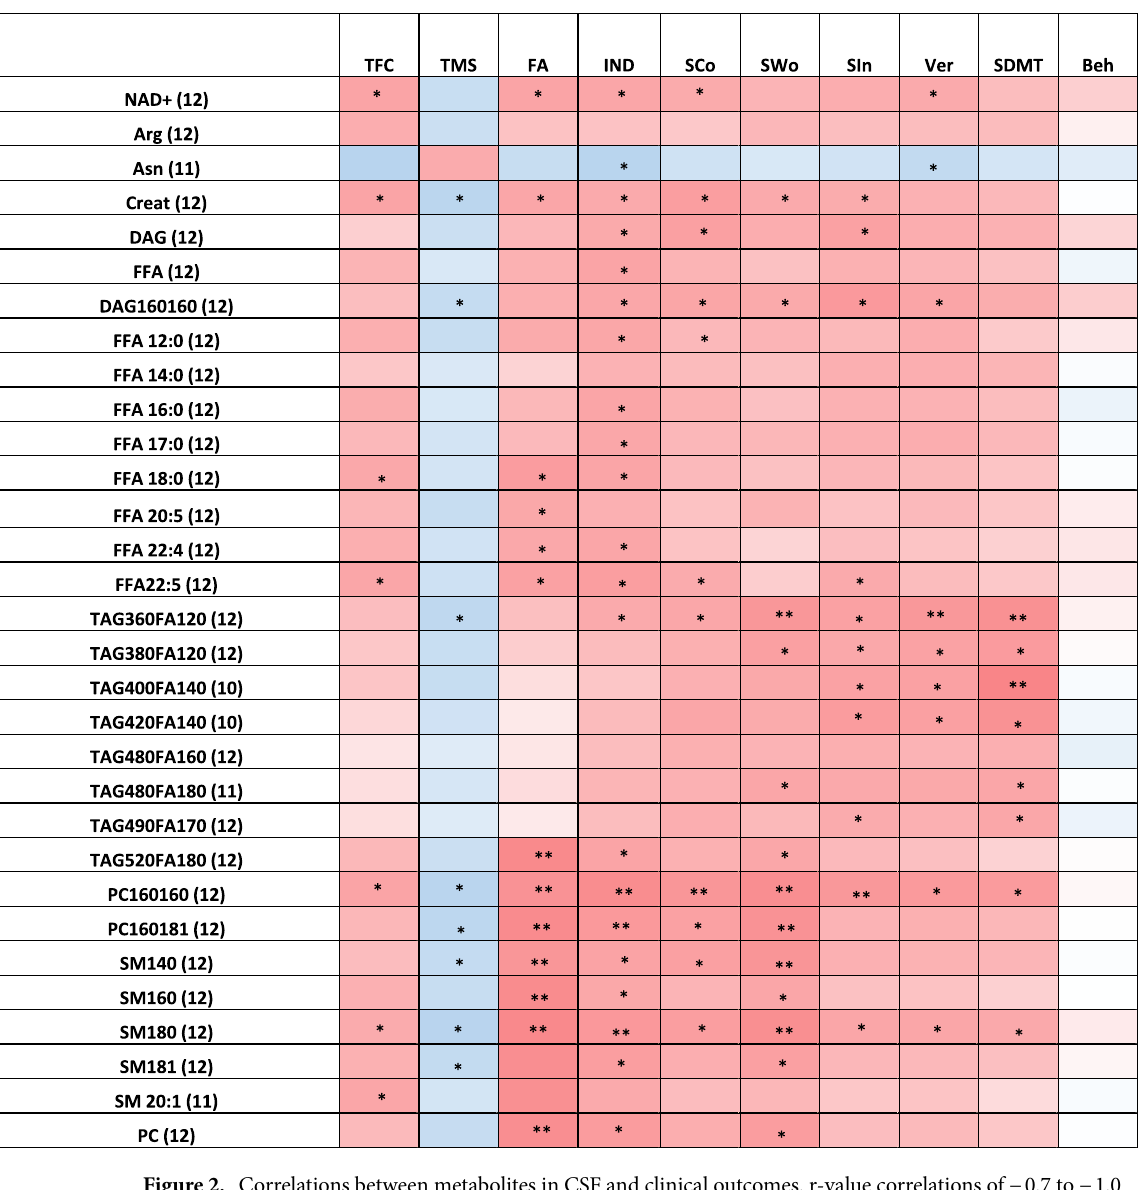
Figure 2. Correlations between metabolites in CSF and clinical outcomes. r-value correlations of − 0.7 to − 1.0 ( ), − 0.4 to − 0.69 ( ), 0.7 to 1.0 ( ) and 0.4–0.69 ( ) are shown; nominal p values are represented as follows: *0.01 < p < 0.05; **0.001 < p < 0.01 and *** p <